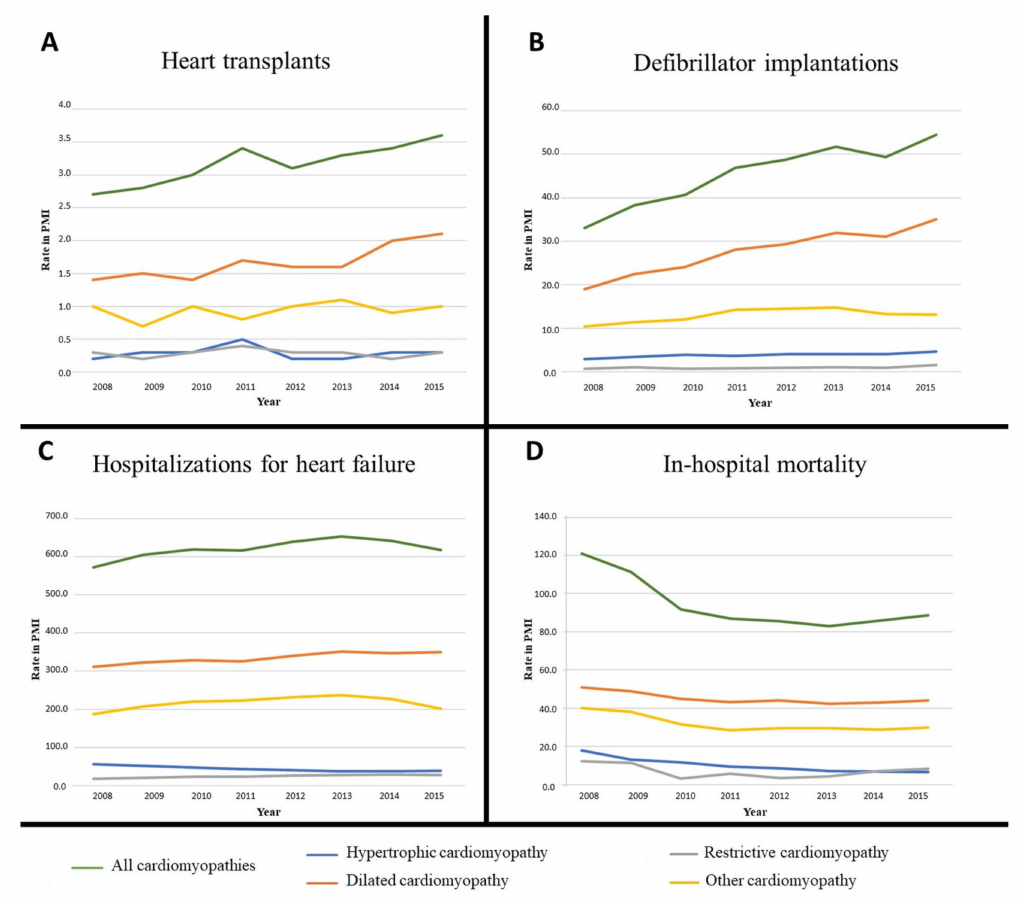
Figure 1. Temporal variations of inpatient prevalence of cardiomyopathy patients with at least one clinical event or procedure from 2008 to 2015: A. Heart transplants; B. Defibrillator implantations; C. Heart failure; D. In-hospital mortality. PMI: Per million